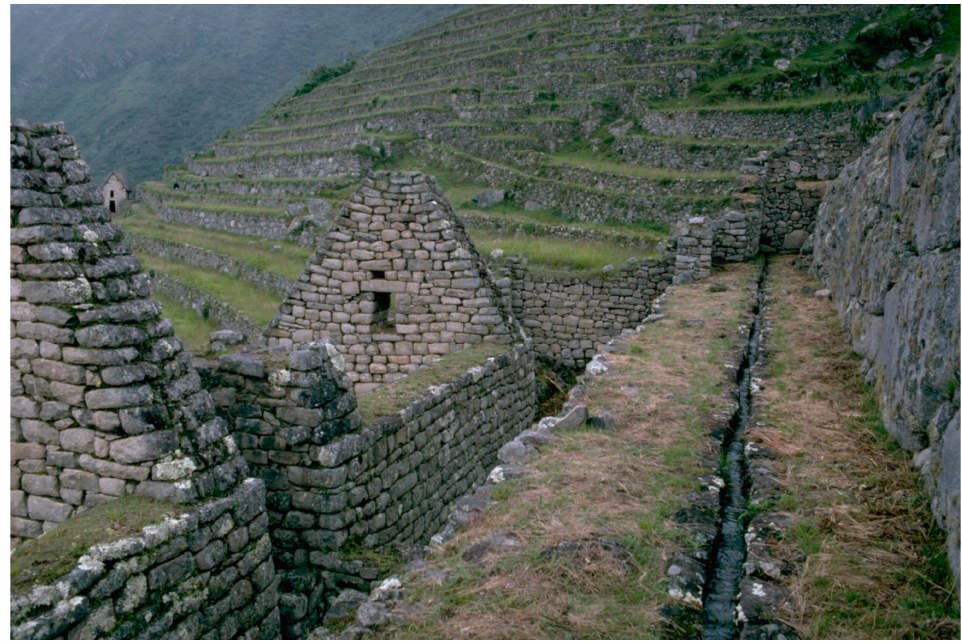
Figure 5. The canal at Machu Picchu runs past grain storehouses on a finely constructed